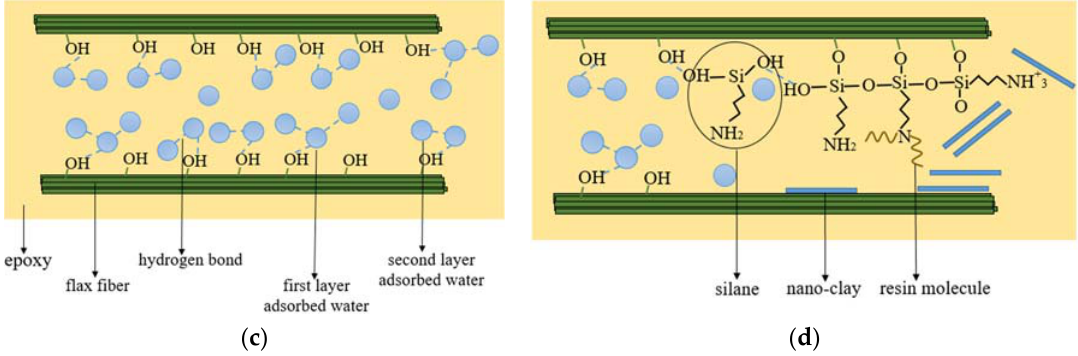
Figure 7. Diagram of water molecule existence and di ff usion path in FFRPs ( a ) untreated FFRPs; ( b ) nano-clay grafted FFRPs; model of water molecule interaction on flax fiber-epoxy interface ( c ) untreated flax fibers ( d ) nano-clay grafted flax fibers.